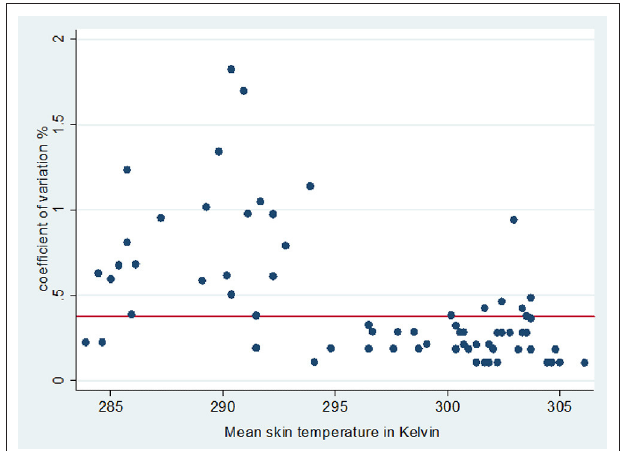
FIGURE 1 | Coefficient of variation (%) plotted against threshold temperature in Kelvin (threshold temperature was the mean of three spot skin temperature at neck, pelvis and flank). The horizontal line indicates the mean skin temperature coefficient of variation for all horses examined.